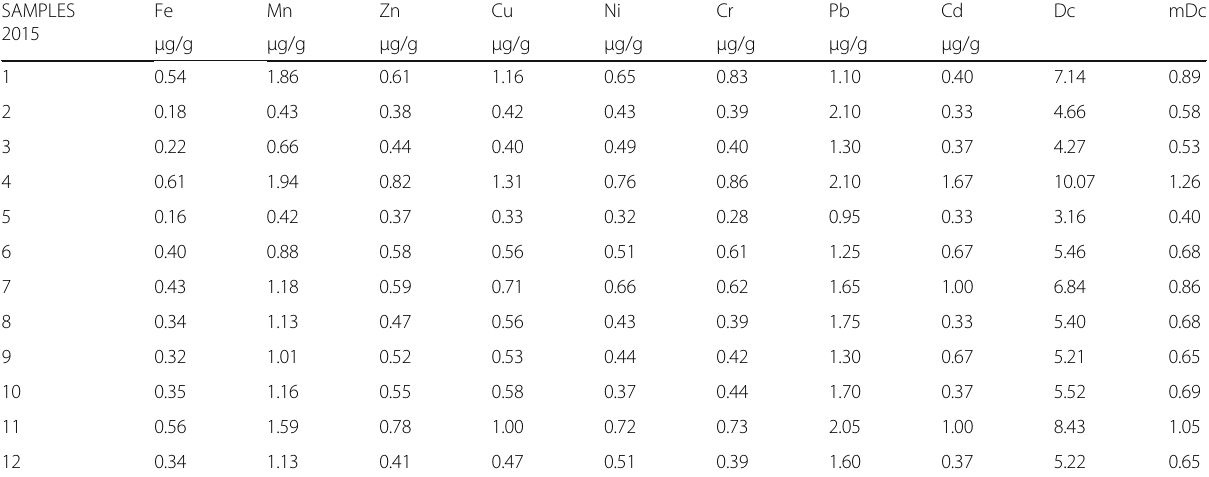
Table 13 Contamination factor, degree contamination, and modified degree contamination for 2015 samples SAMPLES 2015